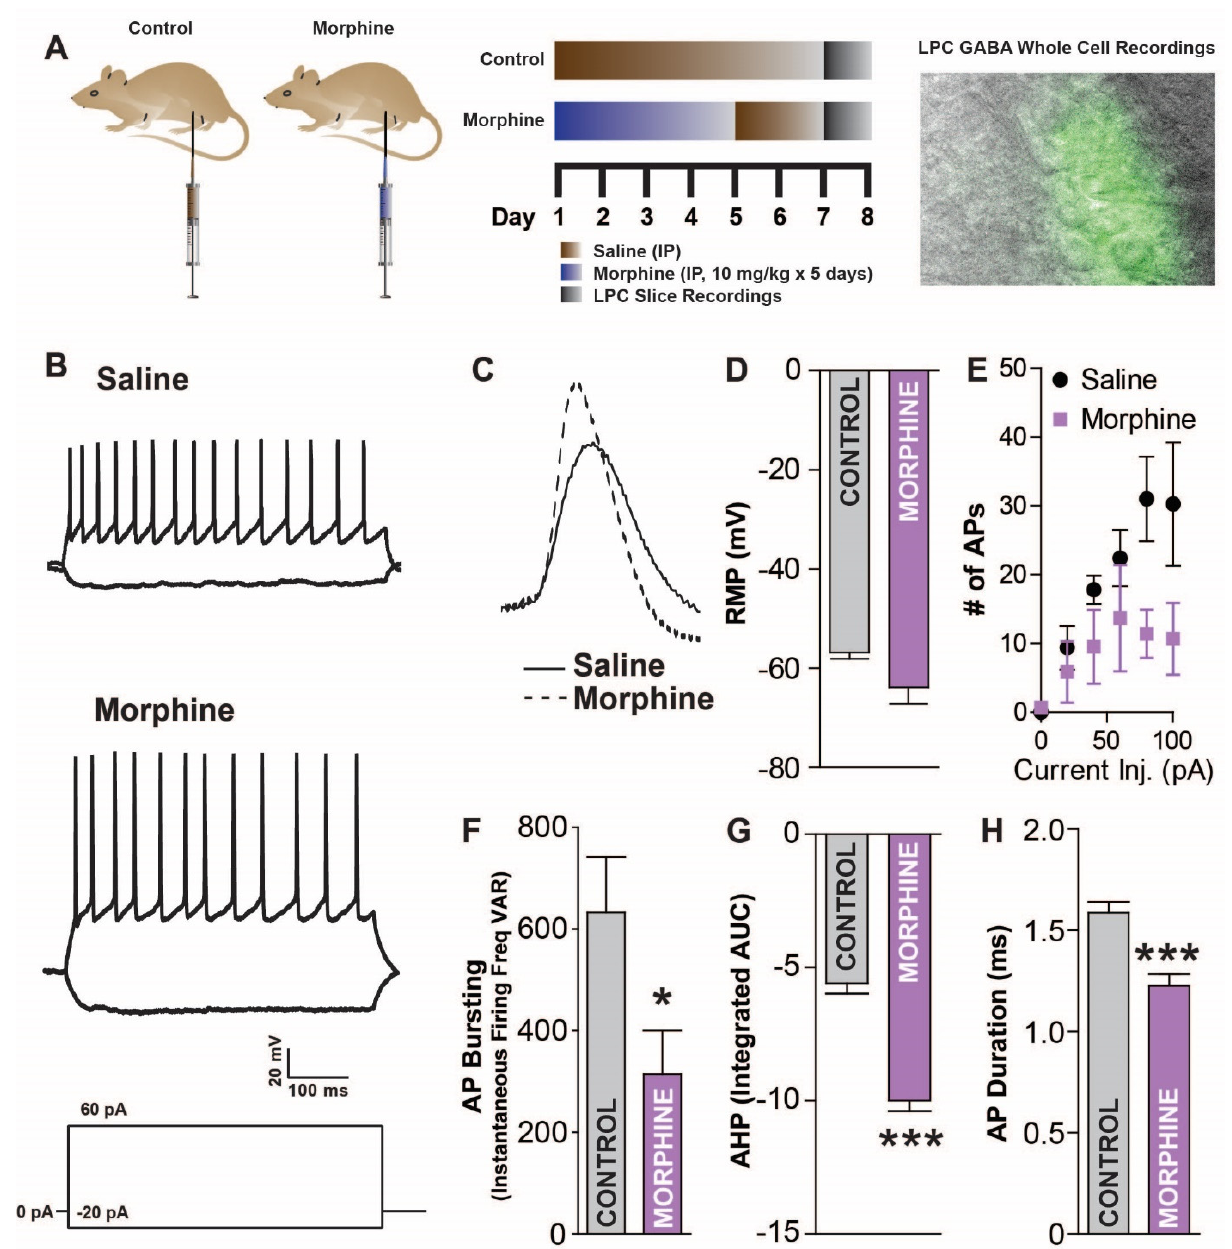
Figure 4. Acute morphine withdrawal reduces lateral paracapsular (LPC) GABAergic neuron excitability. ( A ) Saline or morphine (10 mg/kg) injected mice (IP; days 1–5 morphine/saline, days 6–7 saline), treated as shown in the experimental timeline (top right) were examined for changes in LPC function. Basolateral amygdala (BLA) slices were obtained (day 8) and LPC GABAergic neurons recorded from using whole-cell current-clamp electrophysiology during IR and fluorescent widefield imaging (top right). ( B ) Raw traces of current injection induced depolarizations in LPC neurons for saline- or morphine-treated mice. ( C ) Example action potential (AP) traces in LPC GABA neurons from saline and morphine mice. ( D ) Resting membrane potential is slightly but not significantly lower in morphine mice. ( E ) Number of APs from a depolarizing current (500 ms) is reduced in morphine withdrawal. ( F ) Variability in instantaneous firing frequency during current injection was reduced in morphine withdrawn mice. ( G ) AP afterhyperpolarization (AHP) area under the curve (AUC) is increased in morphine mice. ( H ) AP duration is reduced in morphine withdrawn mice. * p < 0.05, *** p < 0.001.